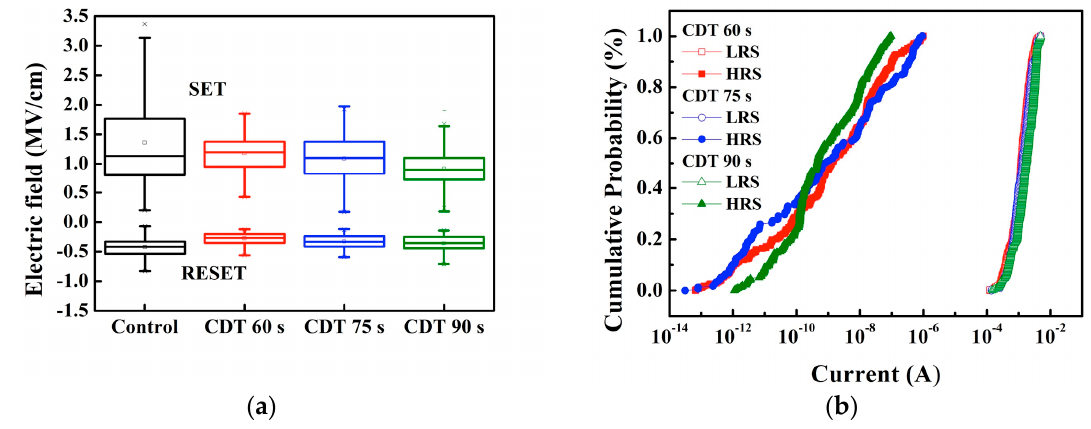
Figure 5. I–V curves in logarithmic scale for the ReRAM devices in the LRS.